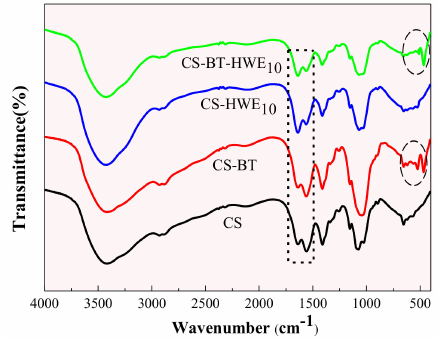
Figure 7. FT-IR spectra of CS, CS-BT, CS-HWE 10 and CS-BT-HWE 10 composite